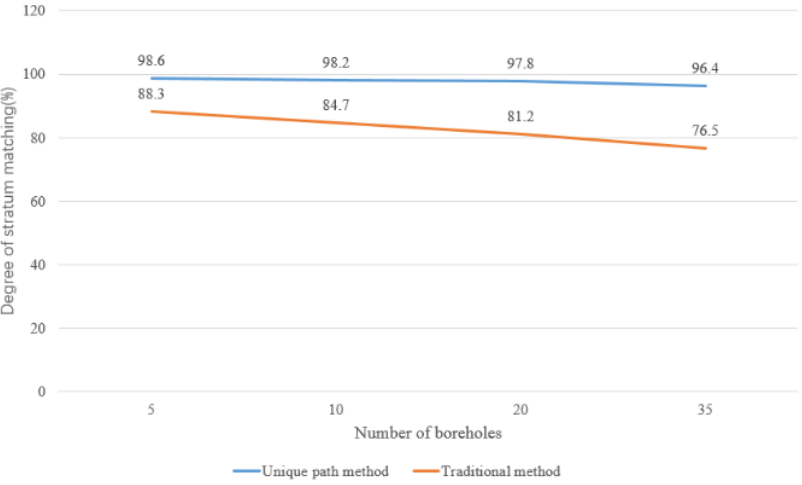
Figure 21. Comparison of degree of stratum matching between two methods with different numbers of boreholes (lack of uniform evaluation criteria).